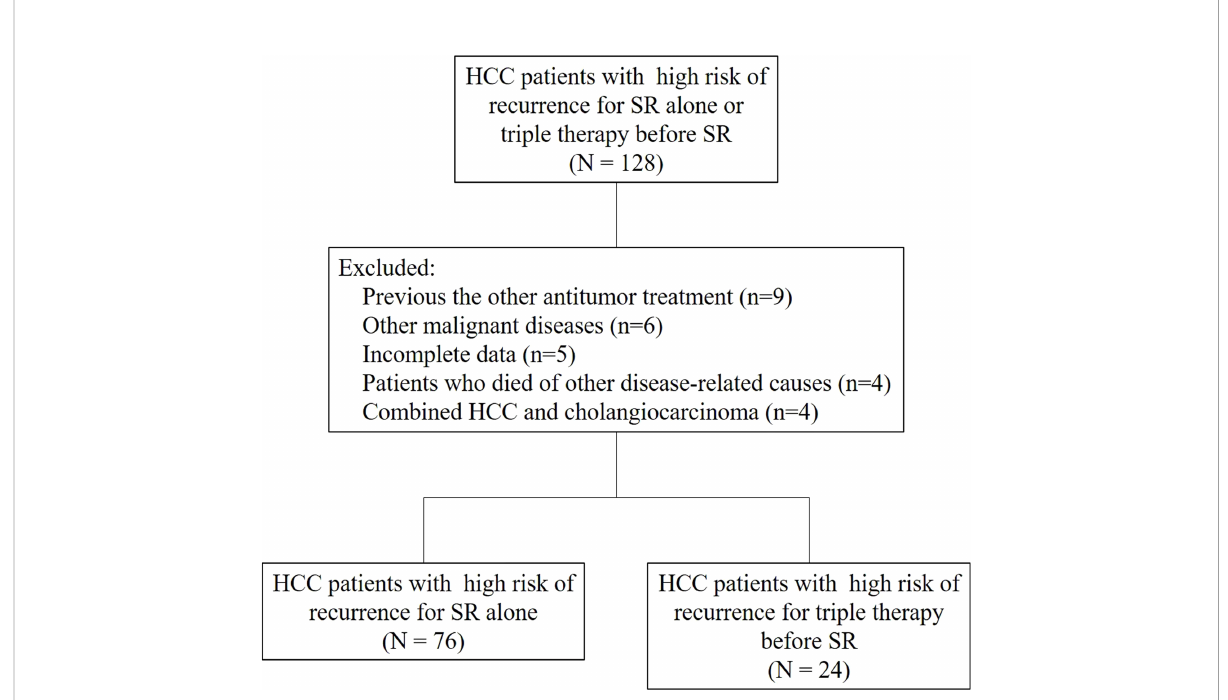
FIGURE 1 Flow diagram of the study selection